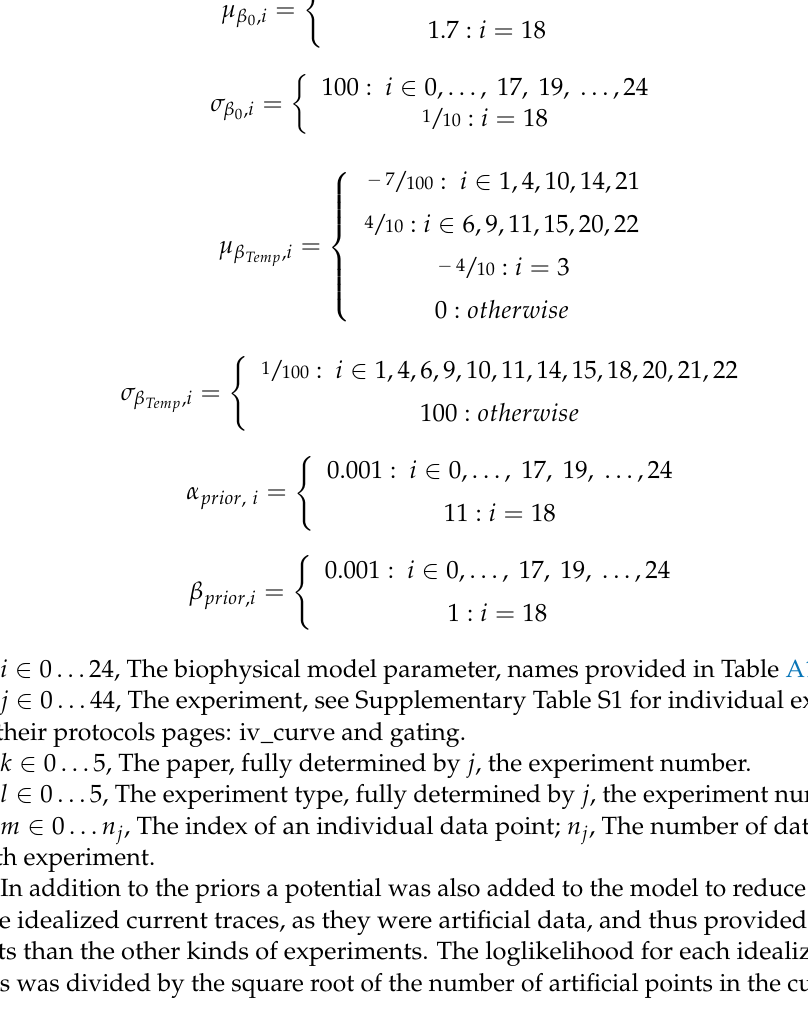
Table A1. The biophysical model